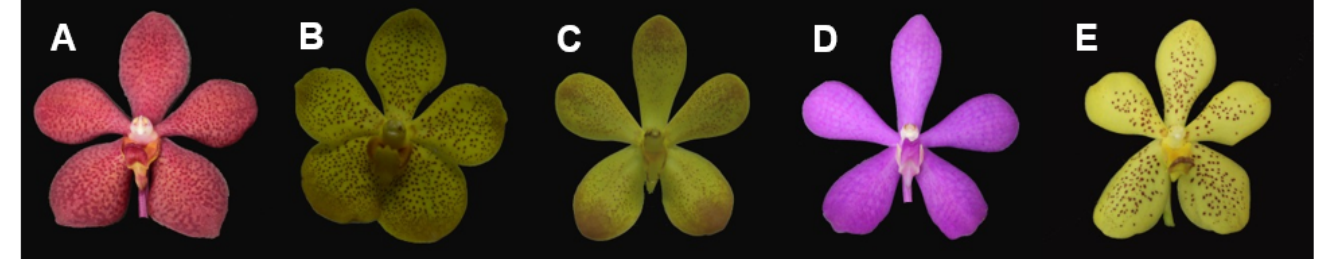
Figure 1. Florets appearance of five Mokara orchid flower hybrids: “Moo-deang” ( A ), “Jao-pra-ya” ( B ), “Duang-porn” ( C ), “Nora-pink” ( D ), and “Dao-lai” ( E ).